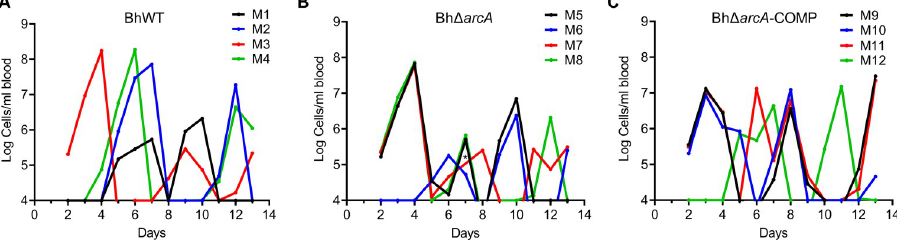
Fig 8. Relapse profile of BhWT, Bh Δ arcA and Bh Δ arcA -COMP. Mice were infected by intraperitoneal needle inoculation with 1 x 10 3 spirochetes of A) BhWT, B) Bh Δ arcA , and C) Bh Δ arcA -COMP. Spirochete numbers in blood were enumerated every 24 h beginning at day 2 post inoculation using quantitative PCR. M1-M12 indicate individual mice used in infection study. Asterisk in panel B indicates sample was not collected for this time point (day 7,